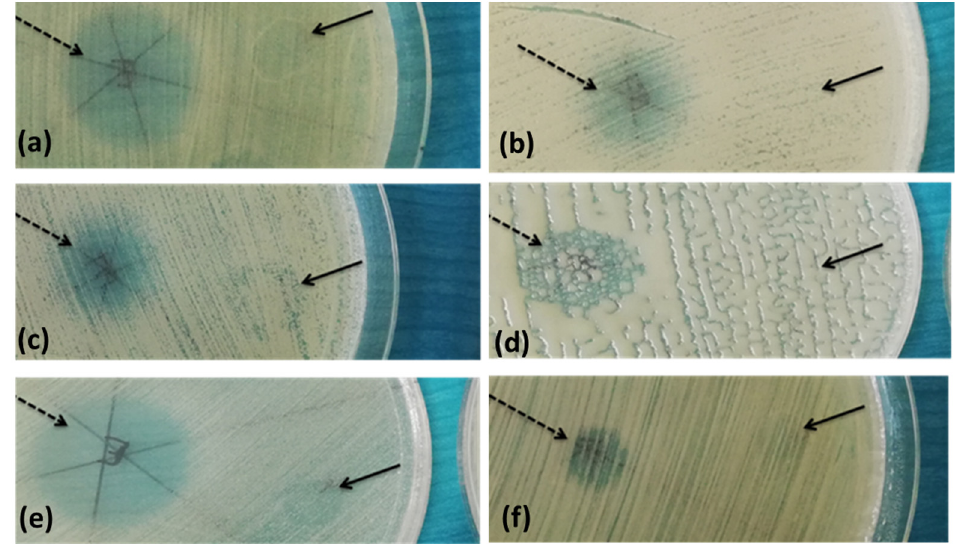
Figure 5. Example of the disk diffusion screening assays of the antimicrobial activity of the tested A. sativum extract against B. cereus ( a ), B. pumilus ( b , c ), B. megaterium ( d ), R. erythrophyllus ( e ), A. globiformis ( f ) strains; dashed arrow— A. sativum inhibition zone, full arrow—solvent inhibition zone.